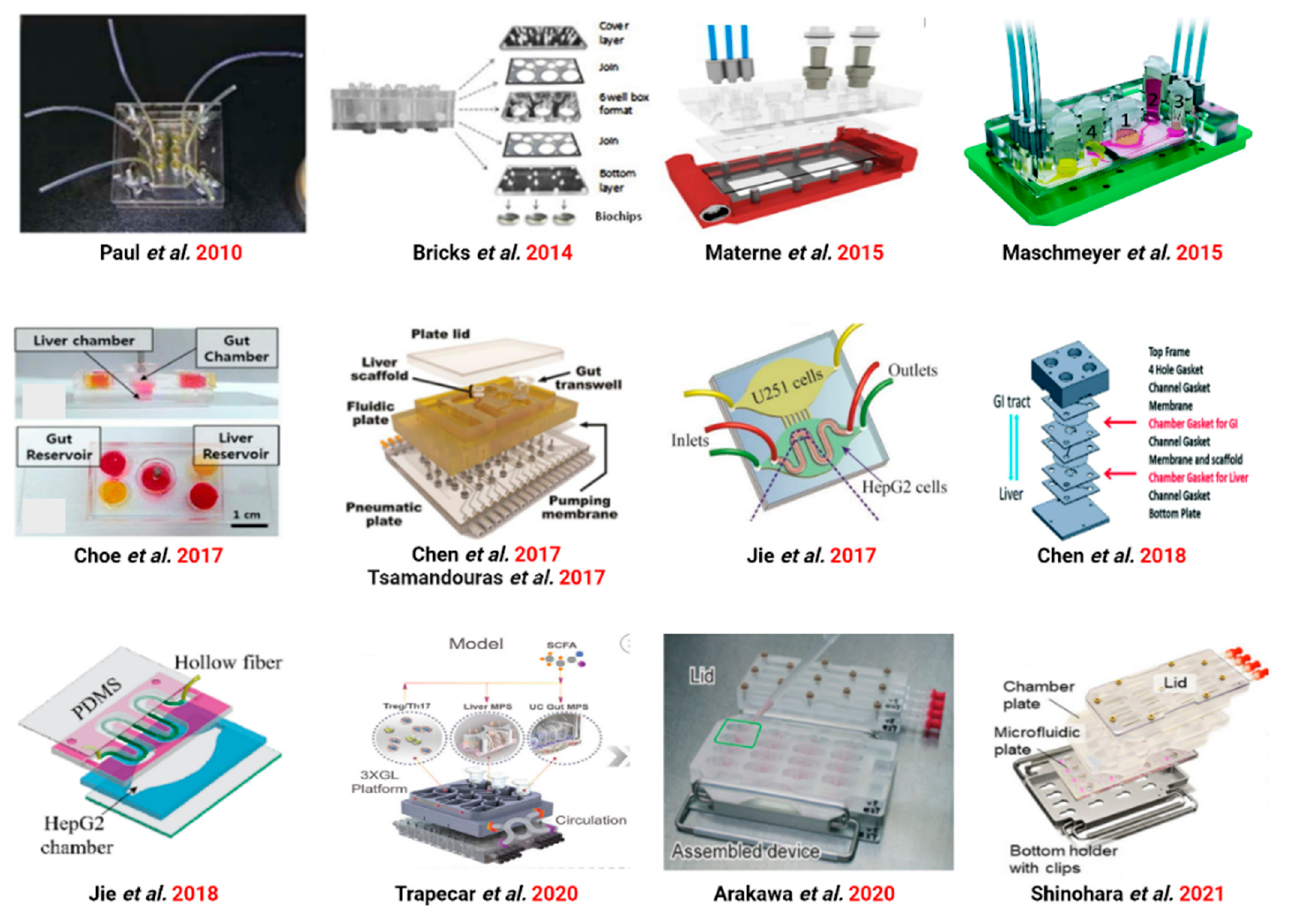
Figure 7. Various GLA-on-chip from 2010 to 2021. Ref. [88] ©Copyright 2010, Royal Soc Chemistry.